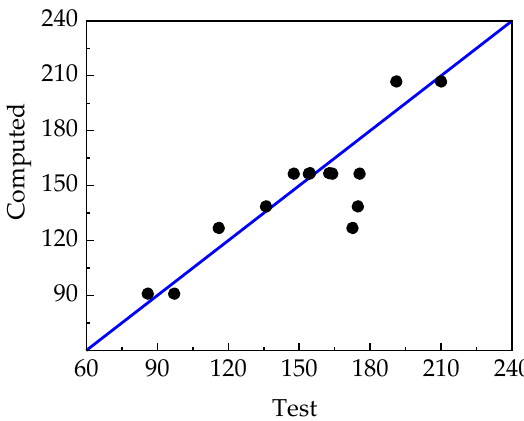
Figure 4. Comparison of test to computed results of crack spacing.